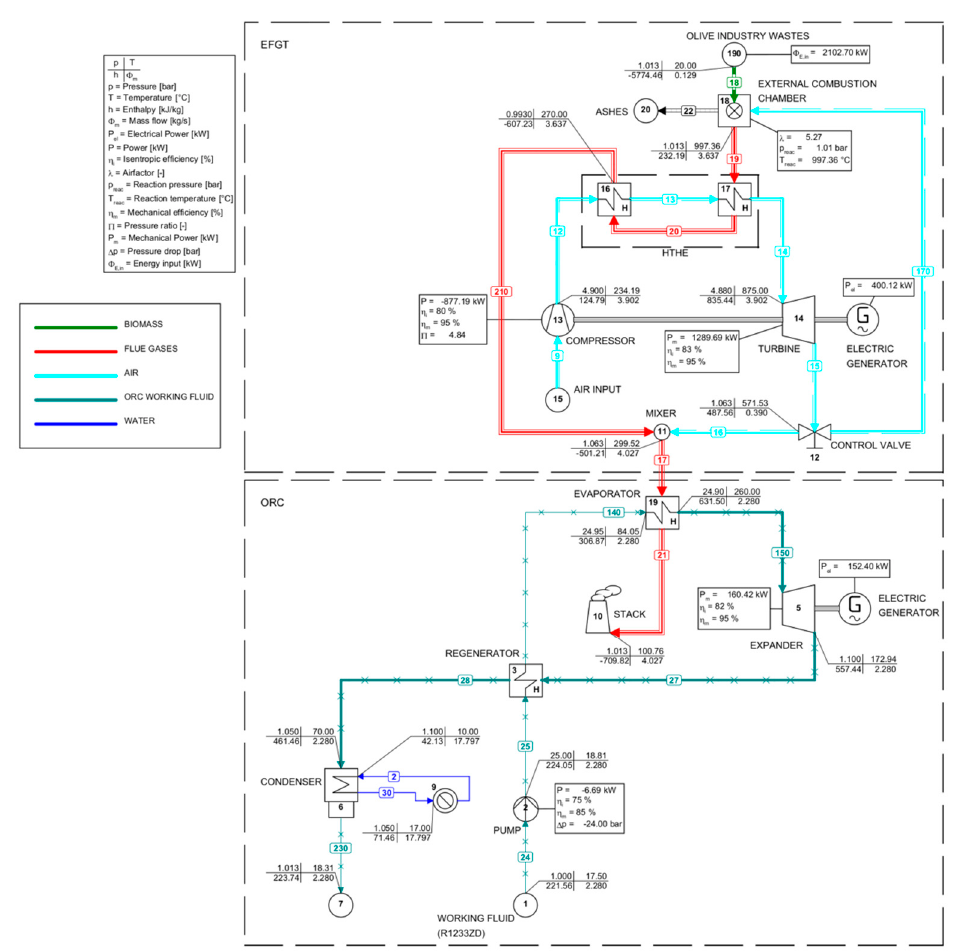
Figure 4. Cycle-Tempo ® layout of the EFGT-ORC system fueled with olive tree pruning and R1233zd as ORC working fluid.